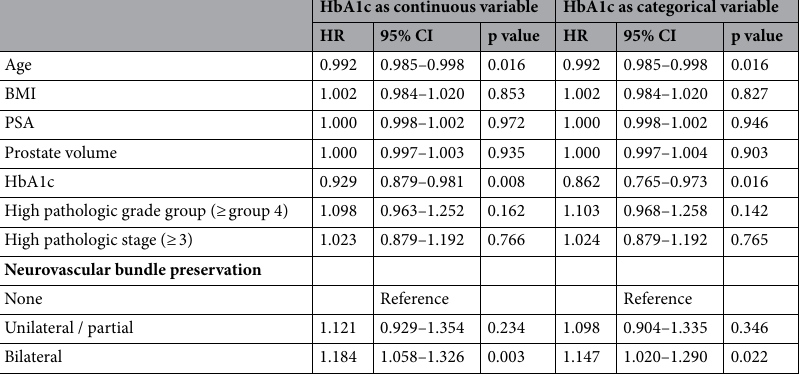
Table 4. Multivariate analyses using Cox proportional hazard model on continence-free survival. BMI Body mass index, DM diabetes mellitus, HbA1c hemoglobin A1c, PSA prostate specific antigen, PSM positive surgical